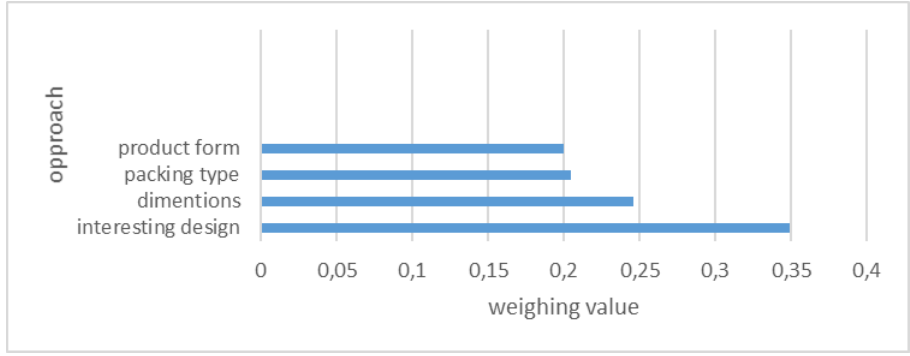
Figure 13: Result of packing sub criteria weighing value (Inconsistency ratio=0.02)